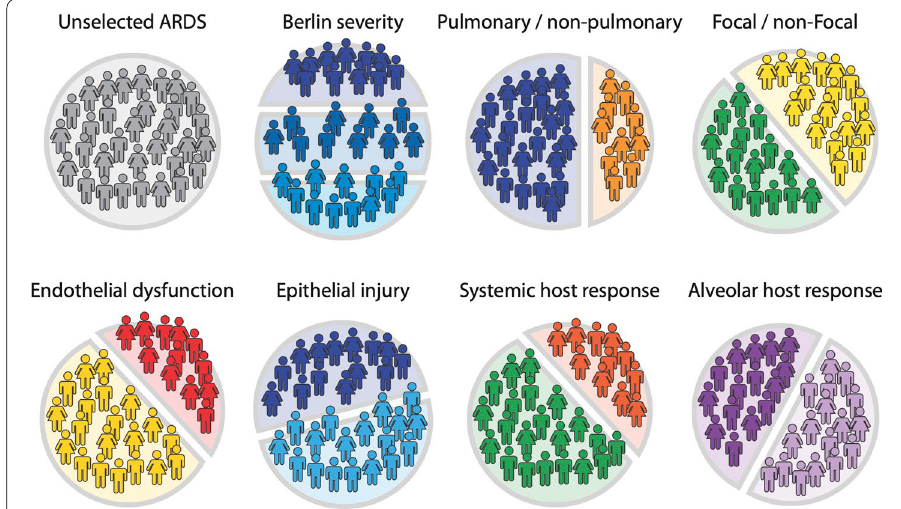
ARDS; Berlin severity with mild, moderate and severe ARDS based on PaO2/FiO2 (light to dark blue); pulmonary (dark blue) and non‑pulmonary (light orange) causes for ARDS; Focal (green) and non‑Focal (yellow) ARDS based on chest CT. Bottom row from left to right: patients with (red) and without (yellow) apparent endothelial dysfunction; with (dark blue) and without (light blue) apparent epithelial injury; hyperinflammatory (orange) and hypoinflammatory systemic host response; hyperinflammatory (dark purple) and hypoinflammatory (light purple) alveolar host